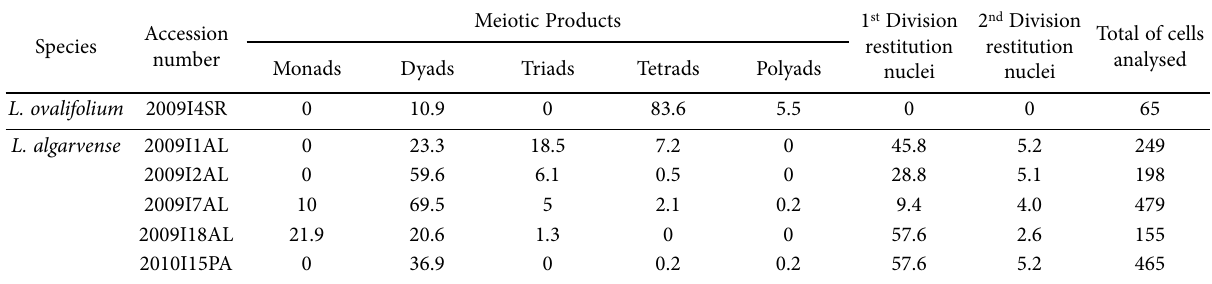
Table 1. Percentage of meiotic products from ex-situ collection Limonium plants used.